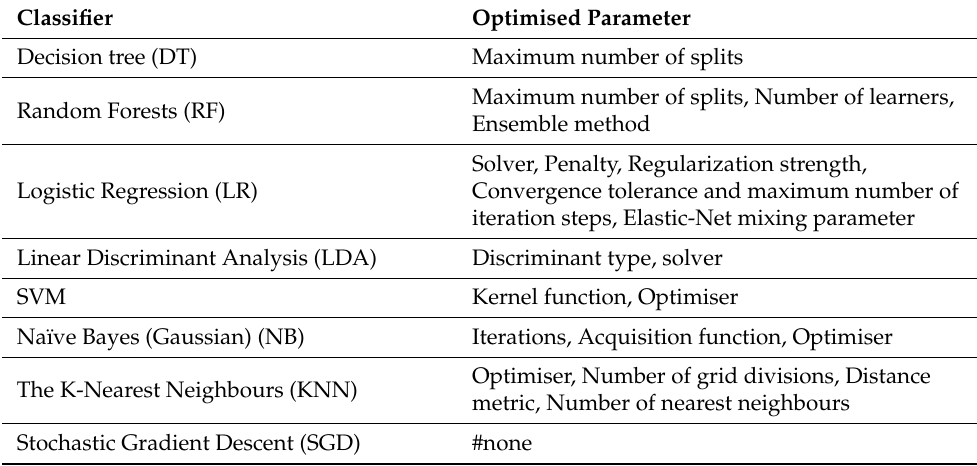
Table 2. Optimised parameters for each particular model (except